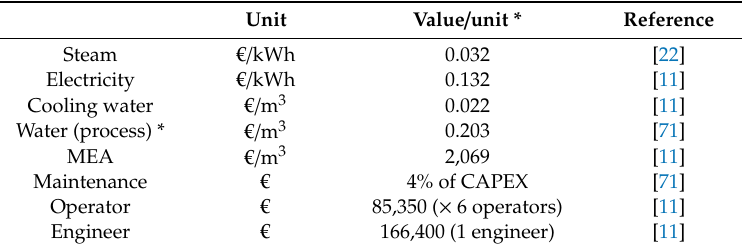
Table 4. Operating cost